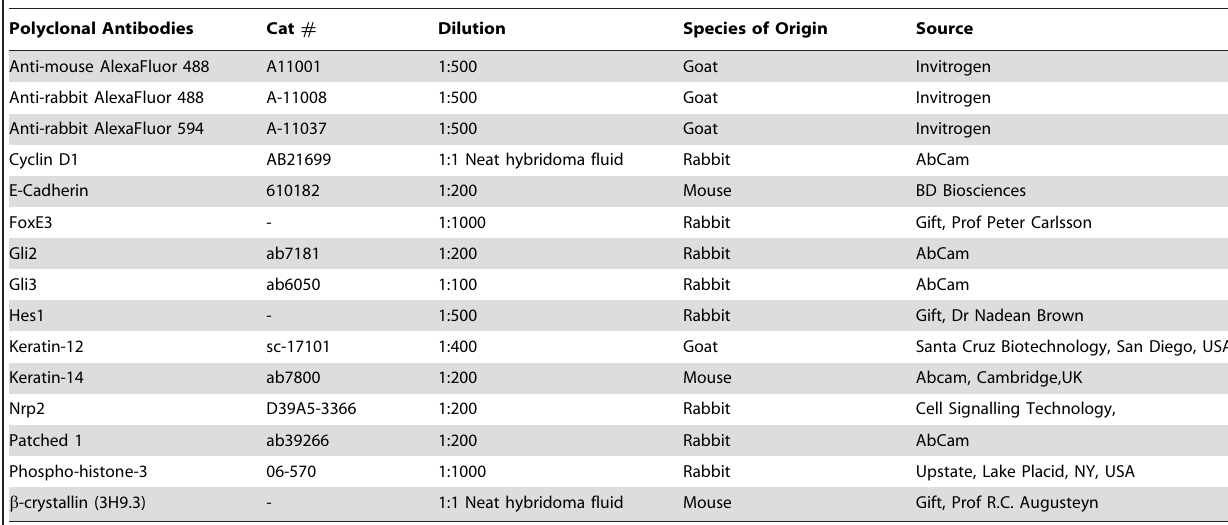
Table 3. Antibodies used for Immunofluorescence.